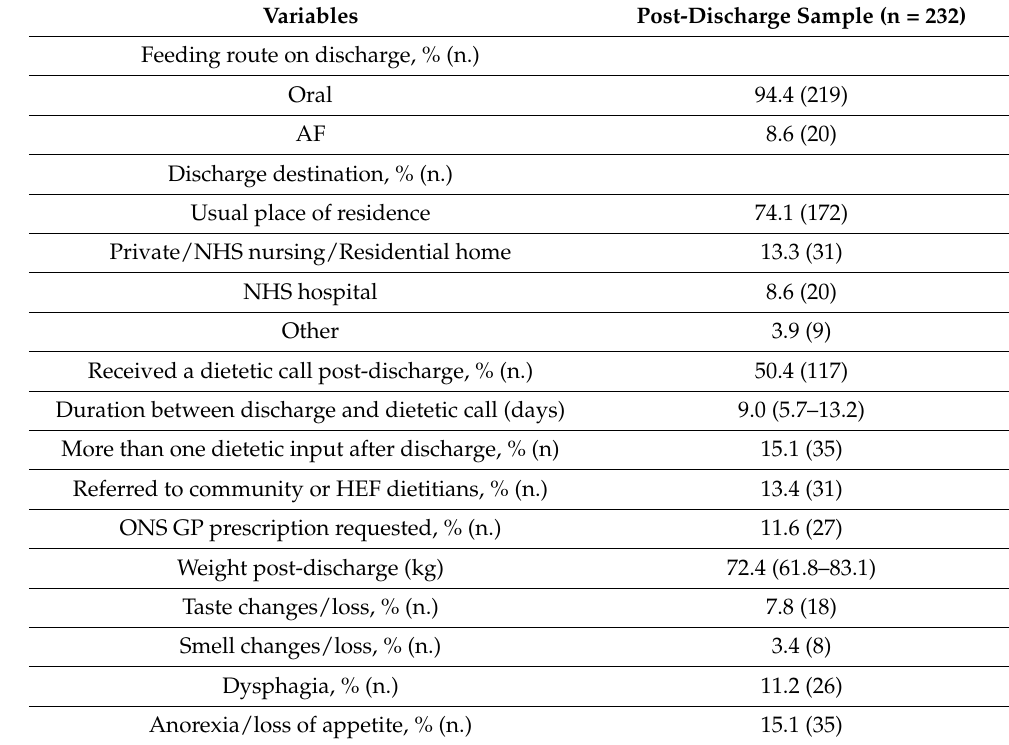
Table 3. Post-discharge descriptive characteristics of the total sample (n =